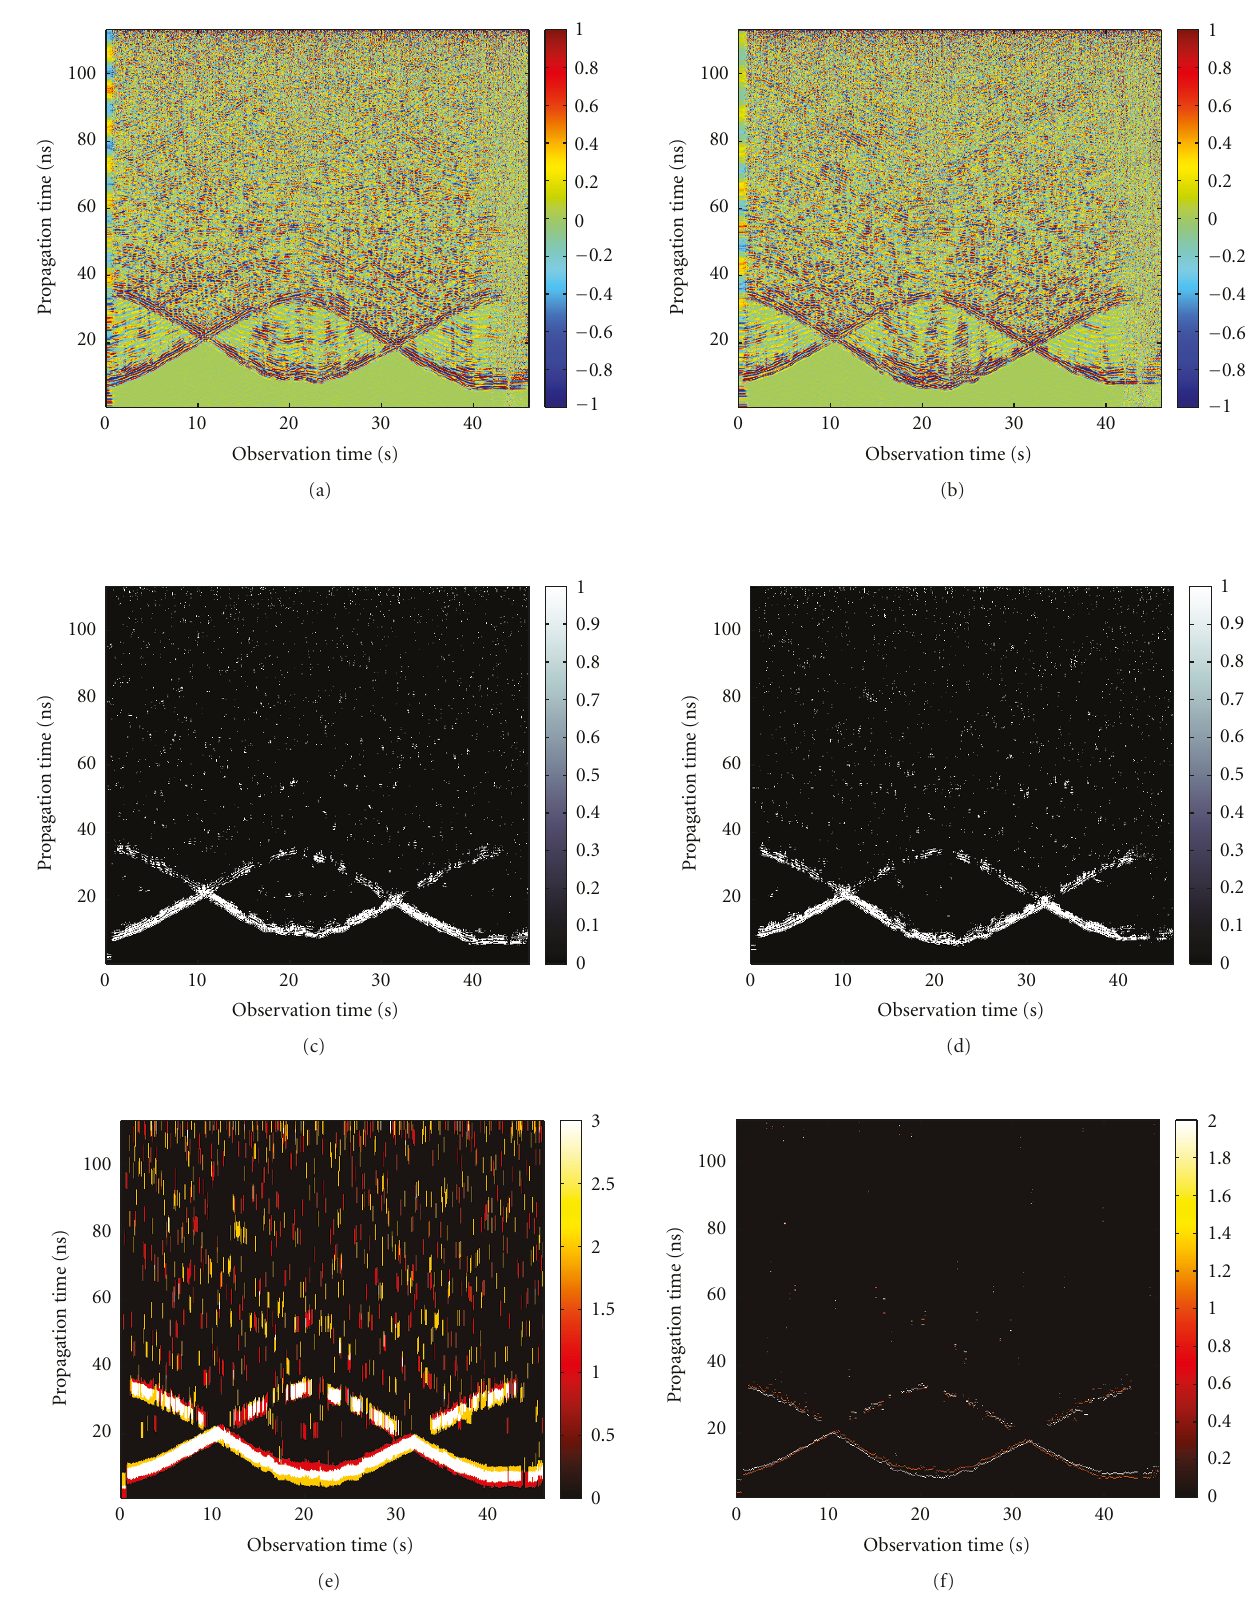
Figure 6: Enhanced signals: (a) radargram for Rx 1 , (b) radargram for Rx 2 ; detector output: (c) radargram for Rx 1 , (d) radargram for Rx 2 ; TOA-association: (e) joint radargram for both Rx k , k = 1,2 with artificially widened potential simple targets, (f) joint radargram for both k = 1,2 with associated TOA Rx k ,